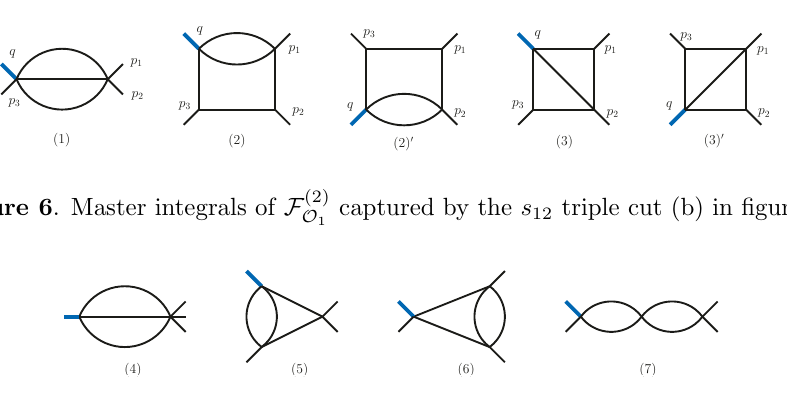
Figure 7 . Master integrals of F (2) that are not captured by the triple cut (b) in (cid:12)gure 5. O 1 where M correspond to the master integrals with label ( i ) in (cid:12)gure 2. Note that the i permutation of two external gluons does not alter the integrals (5) and (6), so for these two master integrals a factor 1 is added to avoid double 2